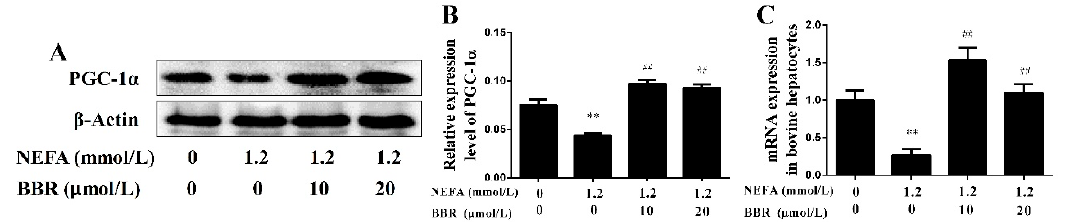
Figure 7. Effects of BBR on the expression of PGC-1 α in bovine hepatocytes. Hepatocyte treatment is described in Figure 5. ( A , B ) Western blot analysis and quantification of PGC-1 α , β -Actin served as an internal control; ( C ) PGC-1 α mRNA expression level changed in different groups. Quantified data are mean ± SD; ** p < 0.01 versus control group; ## p < 0.01 versus NEFA group.